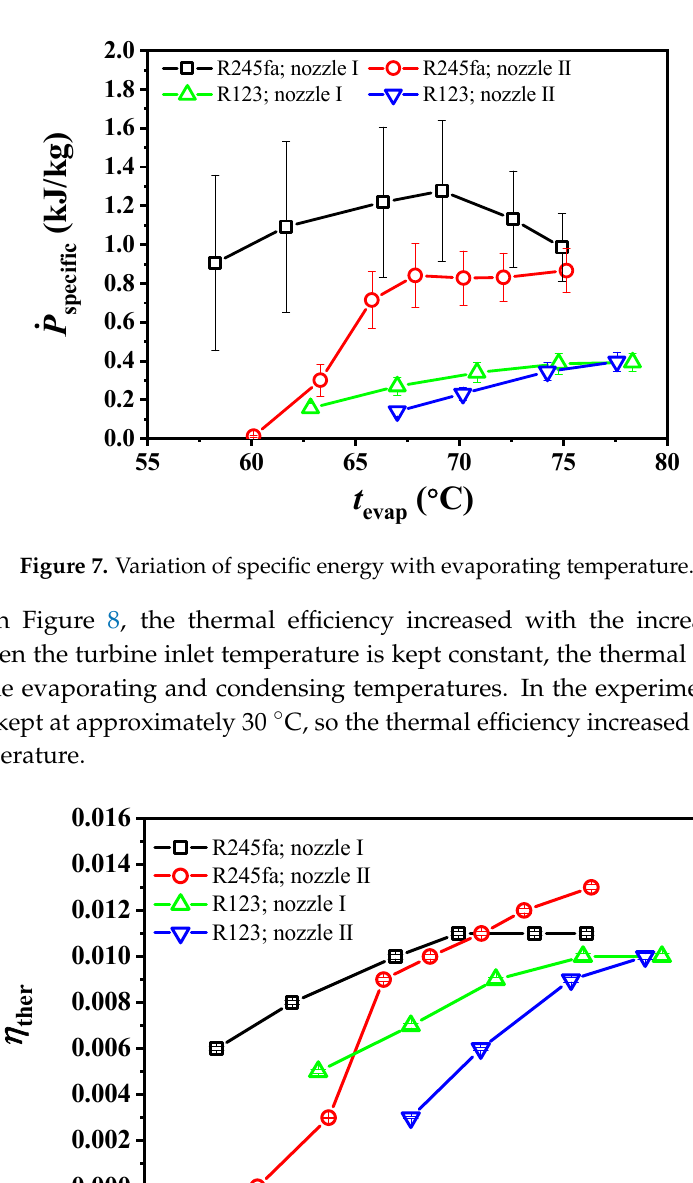
Figure 7 . Variation of specific energy with evaporating temperature.